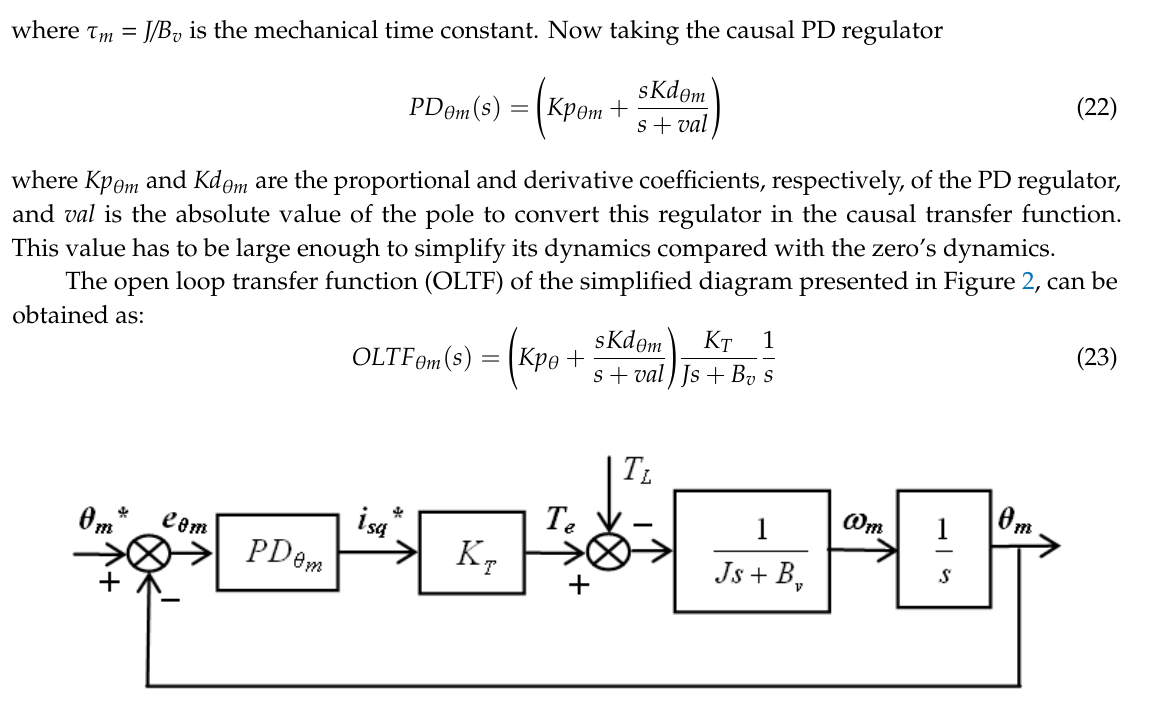
Figure 2. Simplified scheme for proportion derivative (PD) position indirect vector control for the three-phase motor.